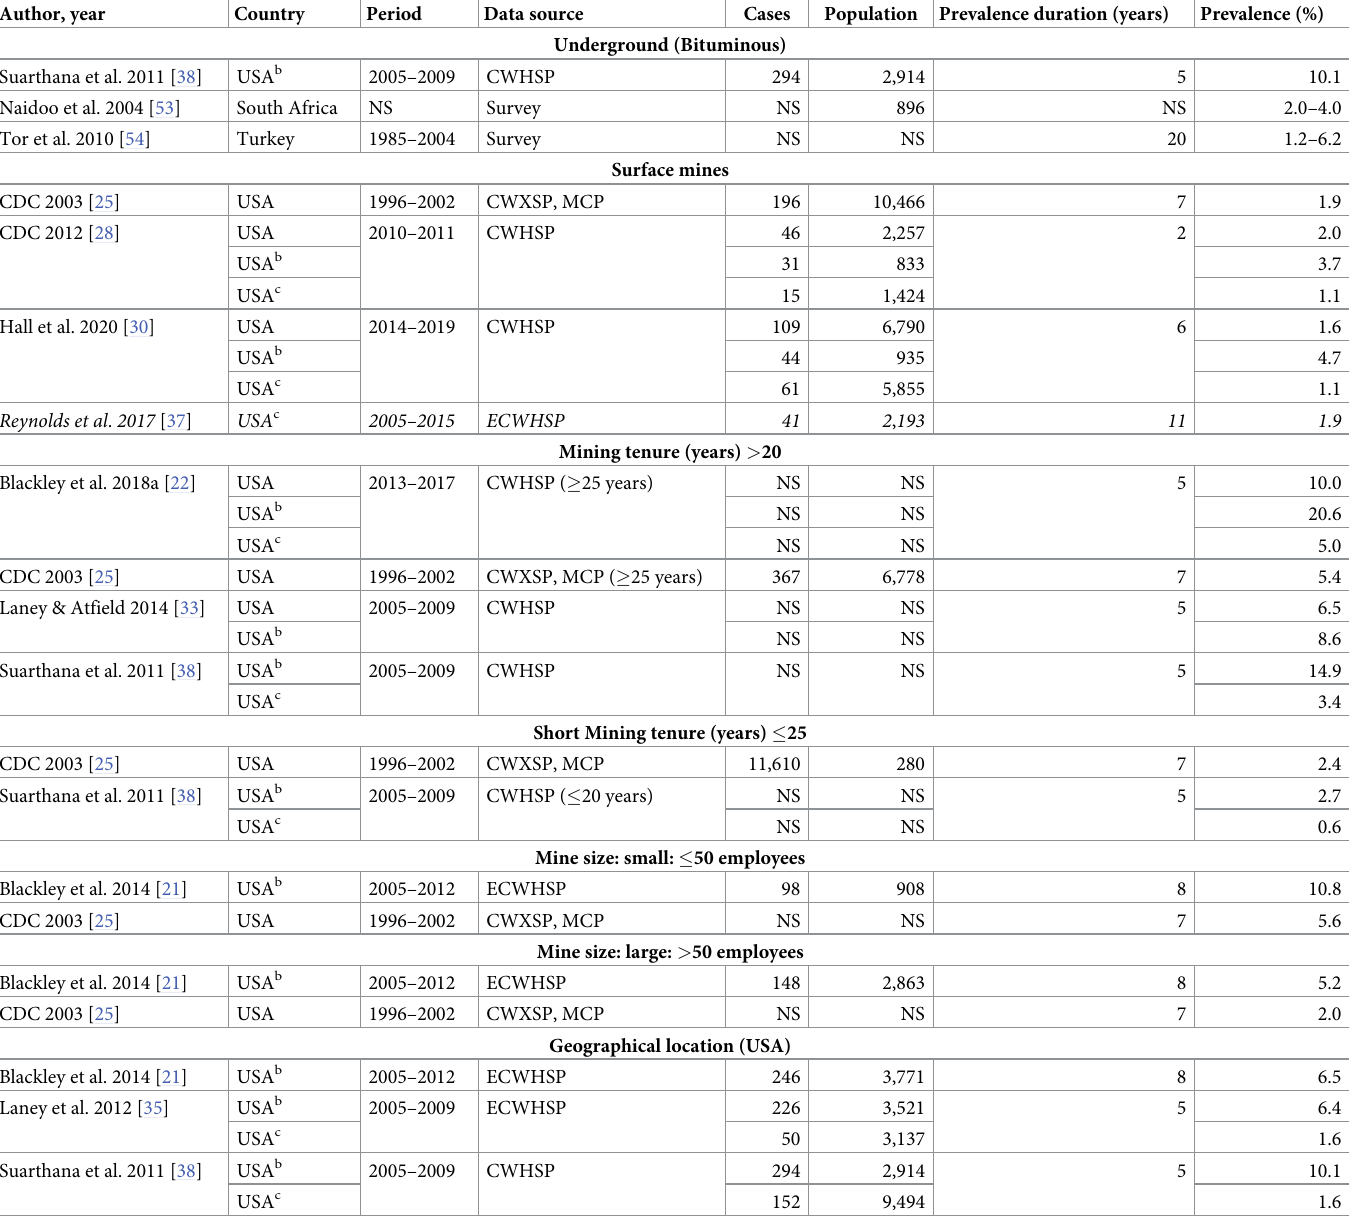
Table 5. Summary of included studies on prevalence of coal workers pneumoconiosis by population sub-groups. Author,